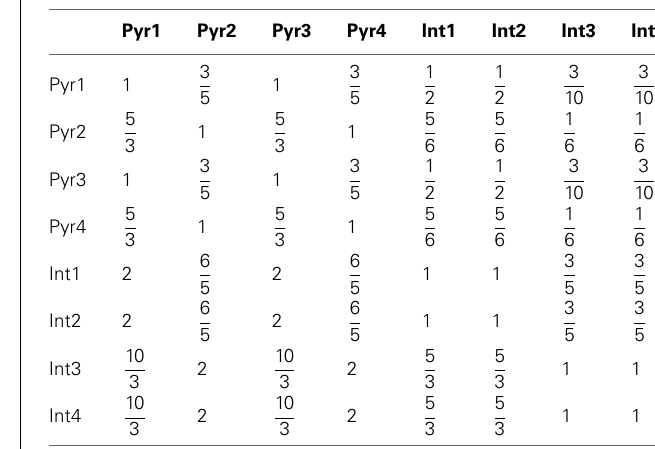
Table 4 | Fraction of neuronal